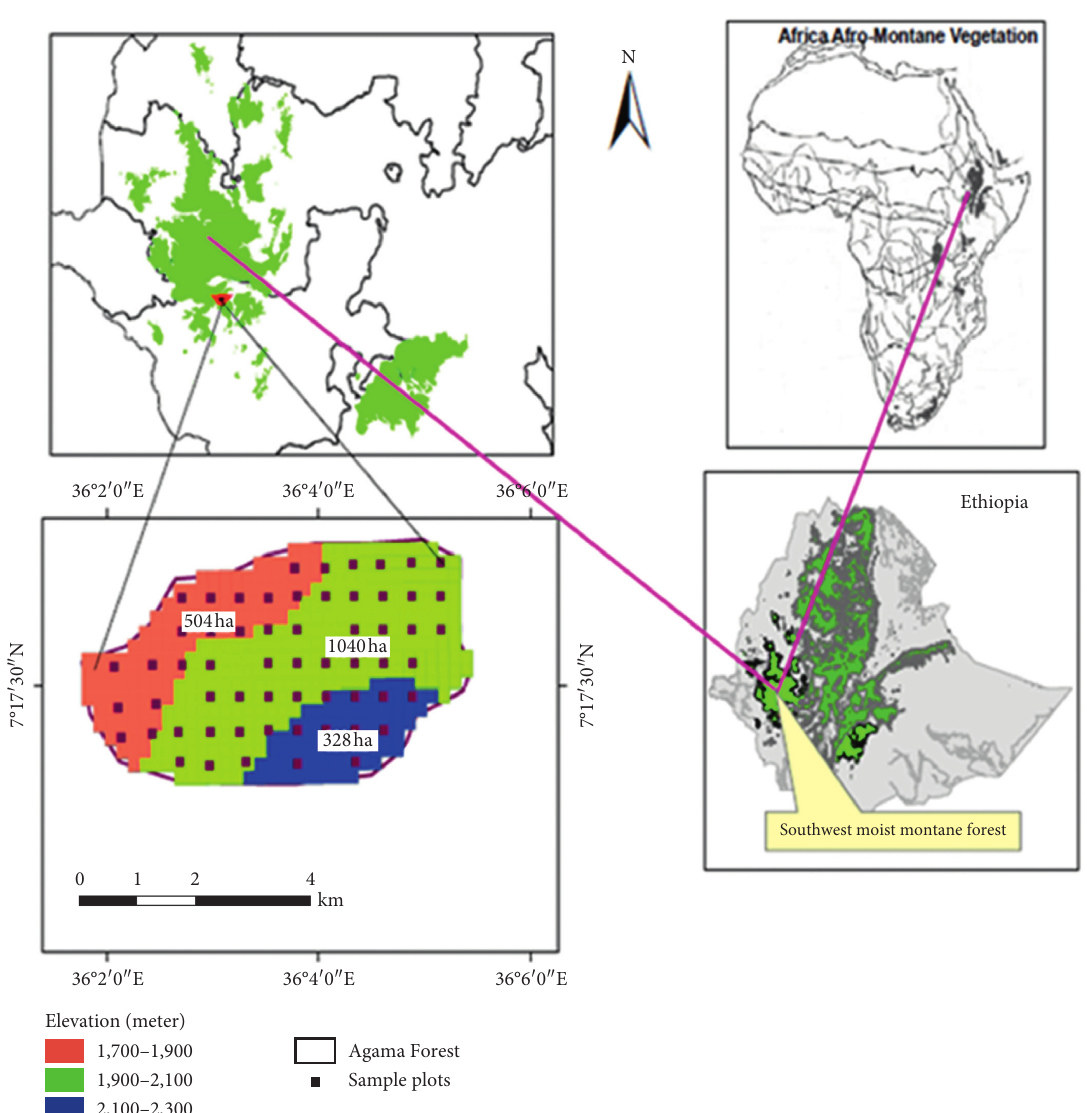
Figure 1: Map and sample plots of the study